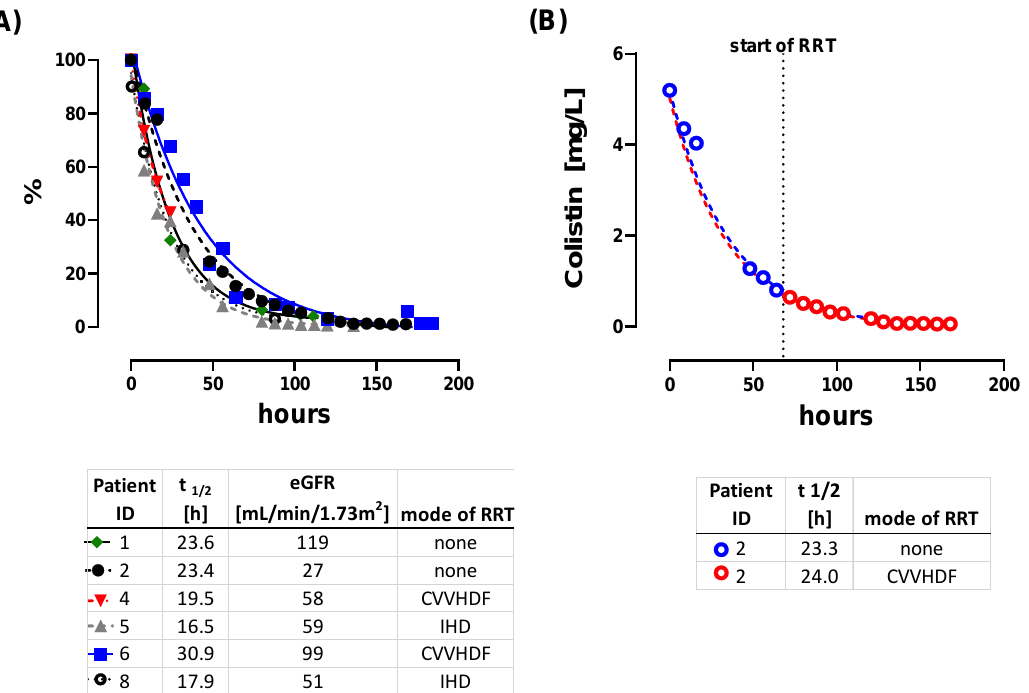
Figure 2. Elimination kinetics of individual patients. Lines show fitted first decay elimination curves. ( A ): normalized elimination kinetics. Patient ID, t 1 / 2 , estimated glomerular filtration rate (GFR)